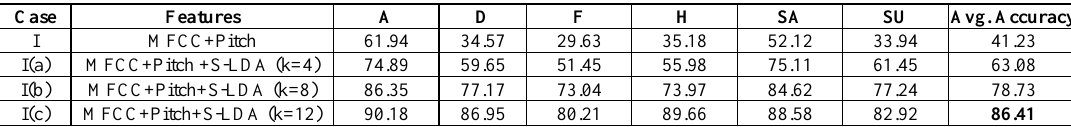
Figure 9. The train and test accuracy of 1-DCNN by applying MFCC+pitch features with proposed on S- LDA algorithm on eNTERFACE database. Table 1. AER for eNTERFACE database using 1D-CNN